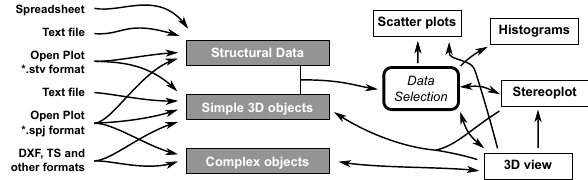
Fig. 2. Schematic working philosophy of Open